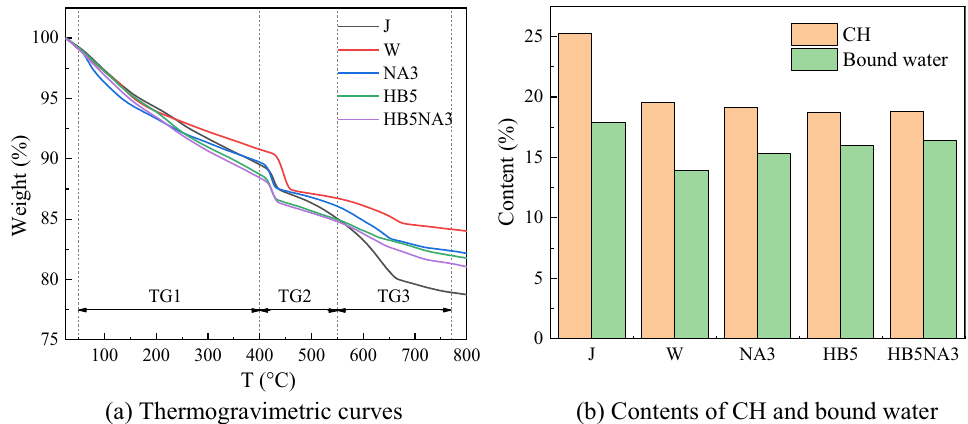
Fig. 16 Thermogravimetric analysis of the cement paste